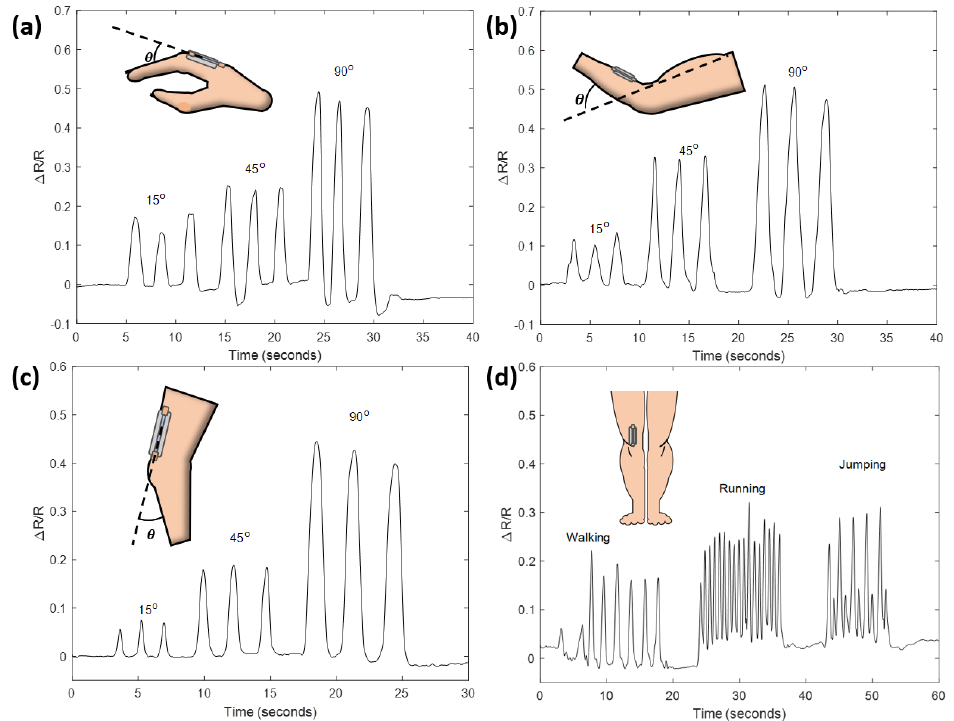
Figure 6. Relative change in resistance in response to different types of motions. ( a ): Finger bending. ( b ): Forearm bending. ( c ): Leg bending. ( d ): Signals corresponding to walking, running and